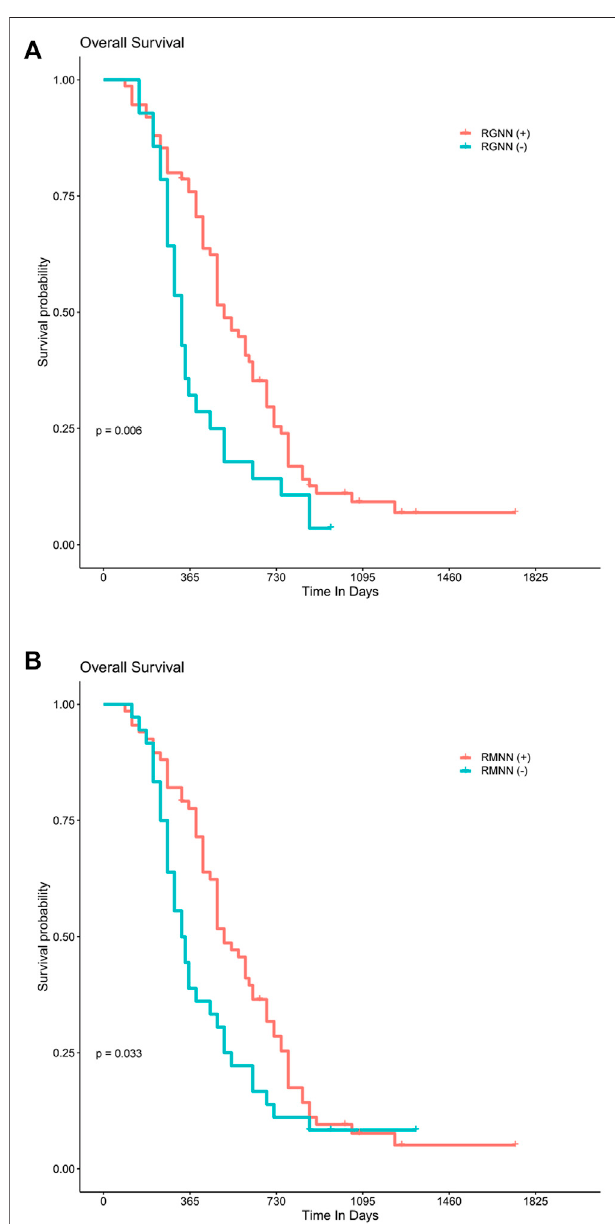
FIGURE 4 | Best-performing model predicting overall survival. Kaplan – Meier survival analysis shows a statistically signi fi cant survival advantage for the Radiomics_GINI_Nearest Neighbors (A) and Resnet50_MIM_ Nearest Neighbors (B) , respectively.